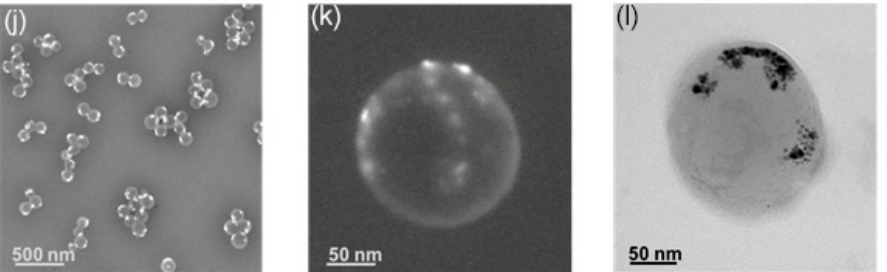
Figure 7. Trojan Eudragit ® microparticles synthesized using the coaxial microfluidic system and loaded with PLGA-RIF and PLGA-Au NPs: ( a ) SEM image of the Eudragit ® microcapsules loaded with PLGA-RIF NPs; ( b ) SEM image of the microcapsules loaded after 2 h of contact with the simulated gastric fluid, pH = 1.2 and Tª = 37 °C; ( c ) SEM image of PLGA-RIF NPs delivered after dissolution of the Eudragit ® microcapsules in the simulated intestinal fluid, pH = 6.8 for 6 h at 37 °C; ( d ) schematic description of the evolution of Trojan microparticles with pH; ( e ) SEM image (secondary electrons) of released PLGA-Au NPs at pH = 6.8; ( f ) SEM image (backscattered electrons) of released PLGA-Au NPs at pH = 6.8. Trojan Eudragit ® microparticles synthesized using the batch method: ( g ) SEM image of the Eudragit ® microcapsules loaded with PLGA-RIF NPs; ( h ) SEM image of the microcapsules loaded after 2 h of contact with the simulated gastric fluid; ( i ) SEM image of PLGA-RIF NPs delivered after dissolution of the Eudragit ® microcapsules in the simulated intestinal fluid; ( j , k ) back-scattered electron micrograph to show the location of Au NPs inside the PLGA NP; ( l ) TEM image of a zoomed Au-loaded PLGA NP.